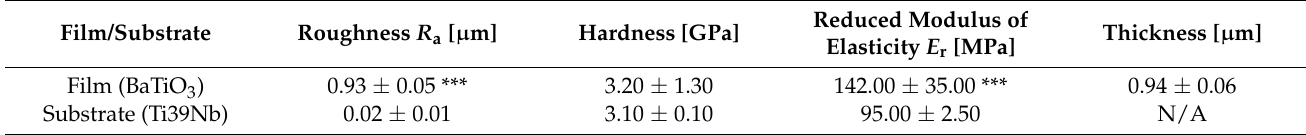
Table 1. Values of the basic parameters of substrate [16] and of BaTiO 3 film.